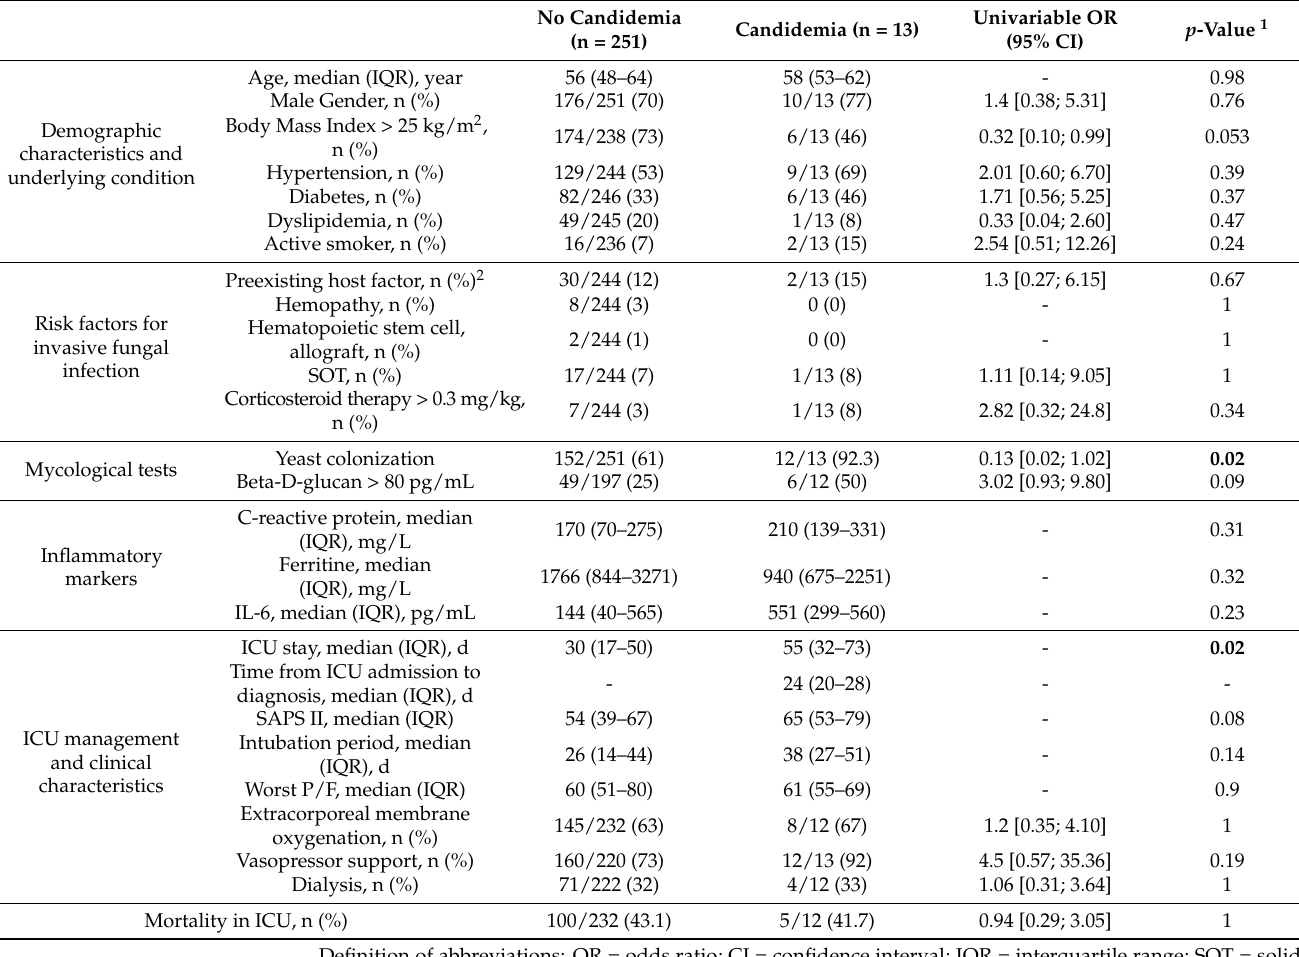
Table 2. Comparison between patients with candidemia and those without during severe COVID-19- related